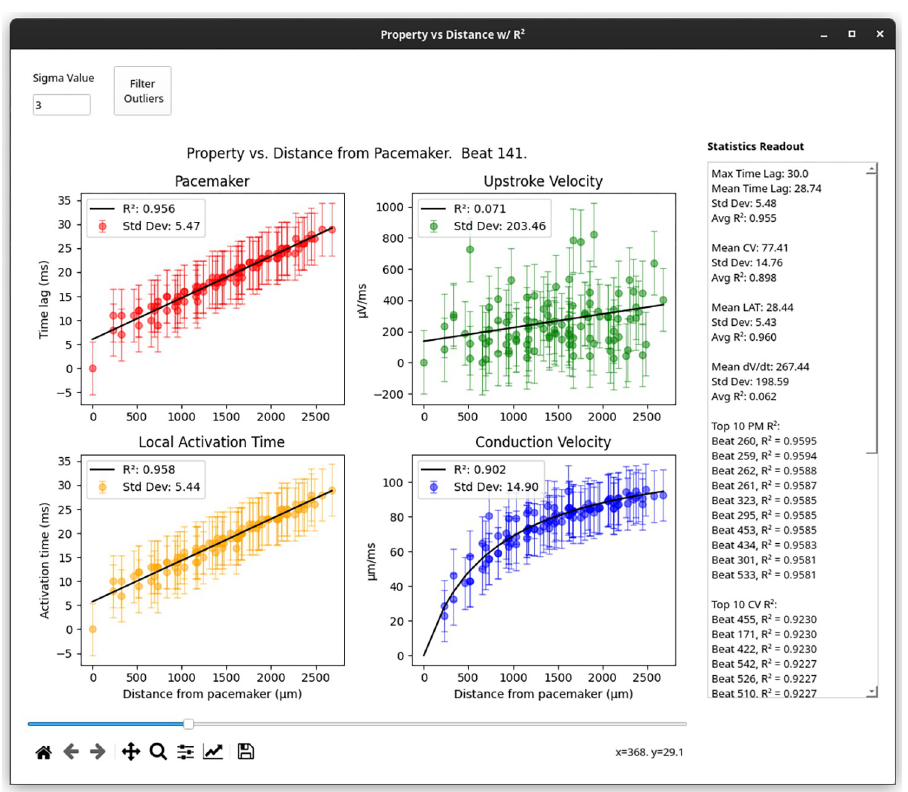
Fig 8. ‘Property vs Distance with R 2 ’ window. Representative plots of each property versus distance from the pacemaker. Statistical quantities, such as average time lag and conduction velocity, as well as top R 2 values, are presented in the ‘Statistics Readout’ text box on the right side of the